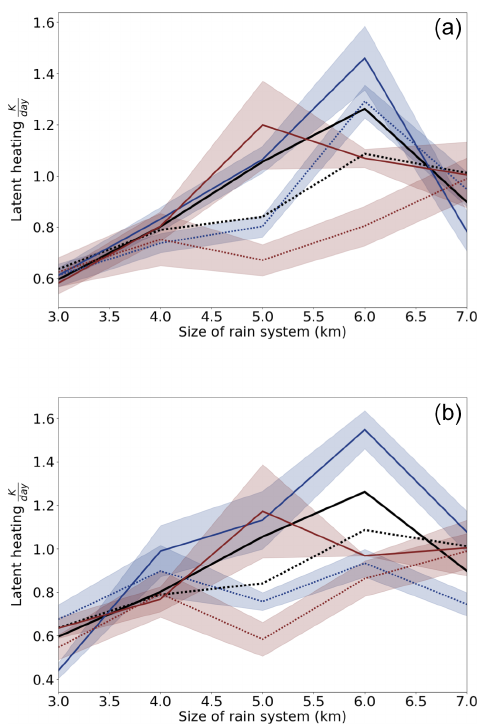
Figure A2. Figure 3 with ± standard error shaded.